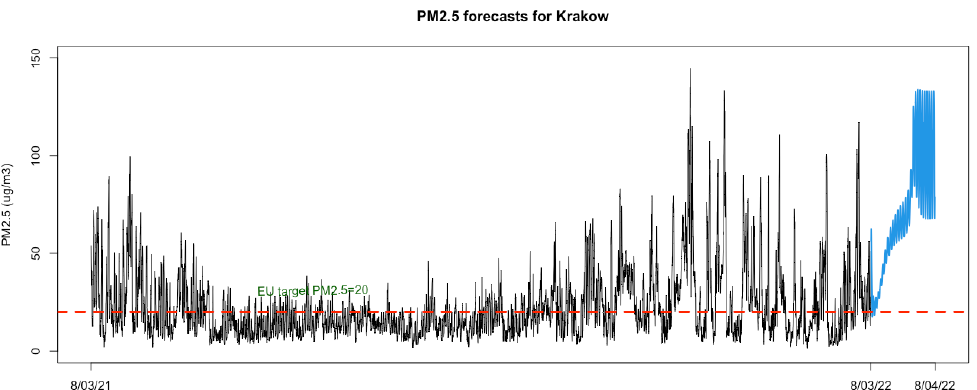
Figure 11. Short-term predictions of PM2.5 in Krakow issued by NNAR(26,14). Source: estimation results. Model Information: Average of 20 networks, each of which is a 26-14-1 network with 393 weight options.